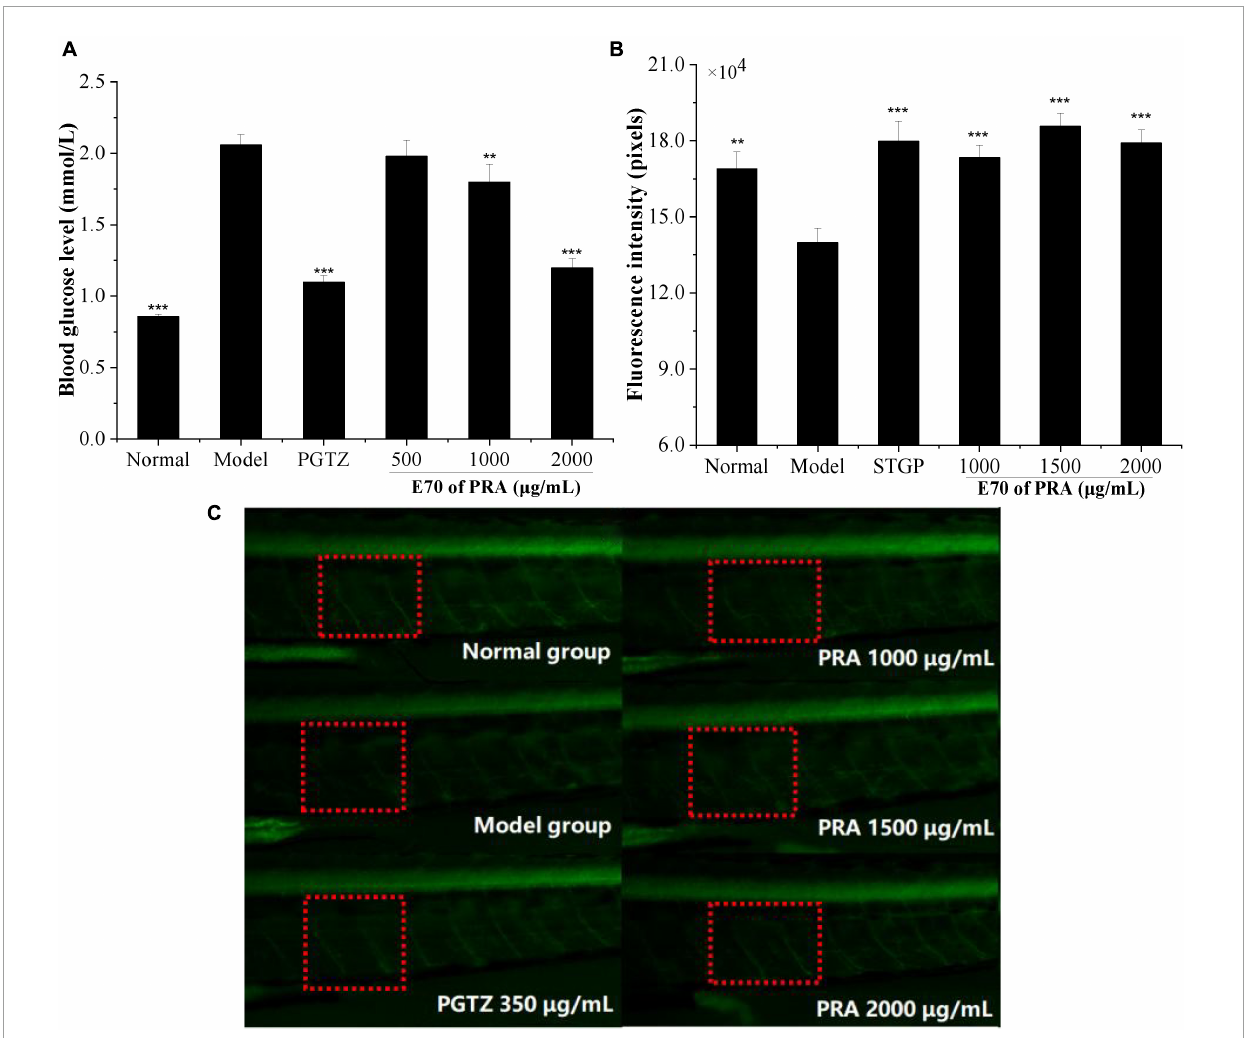
FIGURE5 Blood glucose of zebrafish treated with E70 PRA extracts (A) , the fluorescence intensity of peripheral motor nerve of transgenic zebrafish (B) , and fluorescence diagram of peripheral motor nerve of zebrafish (C) . Compared with the model control group, ** P < 0.01, *** P < 0.001. The red frame was the peripheral motor nerve, and the green fluorescence was the zebrafish motor